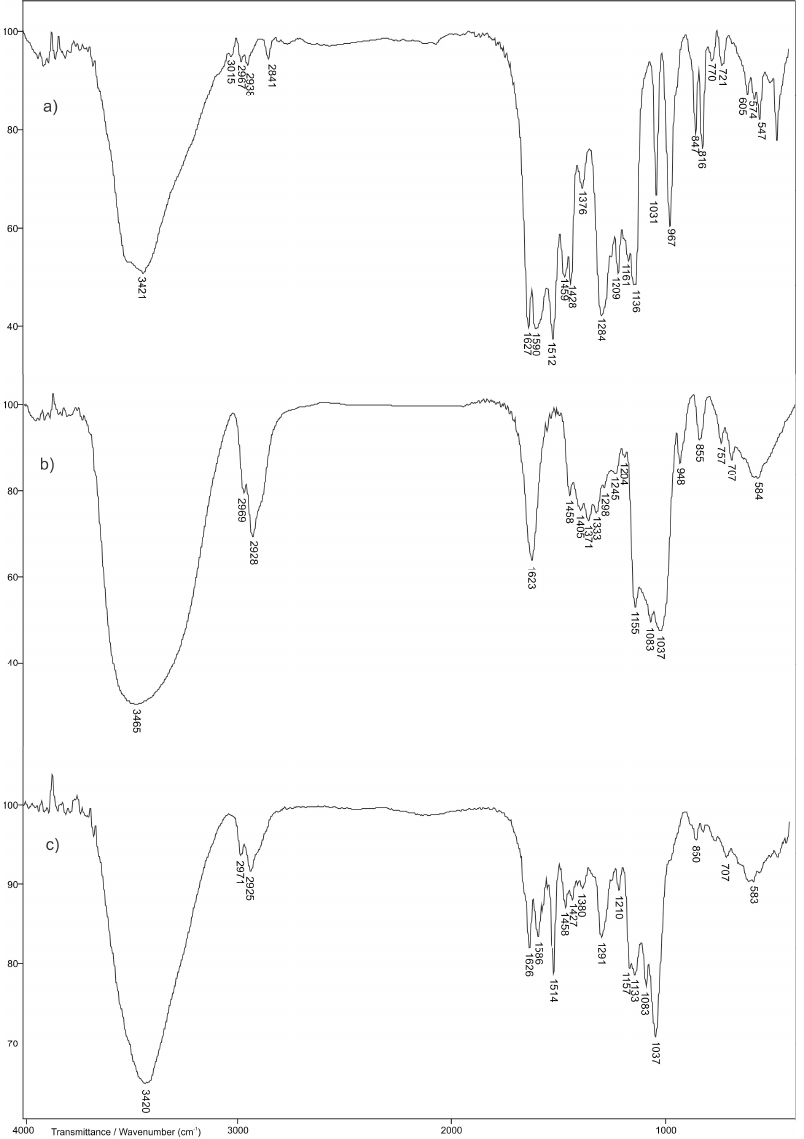
Figure 9. The FTIR spectra: ( a ) curcumin, ( b ) 2 ‐ hydroxypropyl ‐β‐ cyclodextrin, ( c ) curcumin:2 ‐ hydroxypropyl ‐β‐ cyclodextrin inclusion complex. The broad absorption band, with a maximum of absorption at 3465 cm ‐ 1 in the FTIR spectrum of 2 ‐ hydroxypropyl ‐β‐ cyclodextrin (Figure 9b), is a result of valence vibrations of the hydroxyl group from 2 ‐ hydroxypropyl ‐β‐ cyclodextrin. The absorption bands com ‐ ing from valence vibrations of C ‐ H bound are appearing in the FTIR spectrum with a maximum at 2928 and 2969 cm ‐ 1 [55]. In the FTIR spectrum of 2 ‐ hydroxypropyl ‐β‐ cy ‐ clodextrin, the absorption band with a maximum at 1623 cm ‐ 1 comes from O ‐ H deforma ‐ tive vibration in the plane [56]. The asymmetric and symmetric C–H deformative vibra ‐ tions in the plane give absorption bands at 1458 and 1371 cm ‐ 1 in the FTIR spectrum of 2 ‐ hydroxypropyl ‐β‐ cyclodextrin, respectively. The absorption band at 1155 cm ‐ 1 indicates